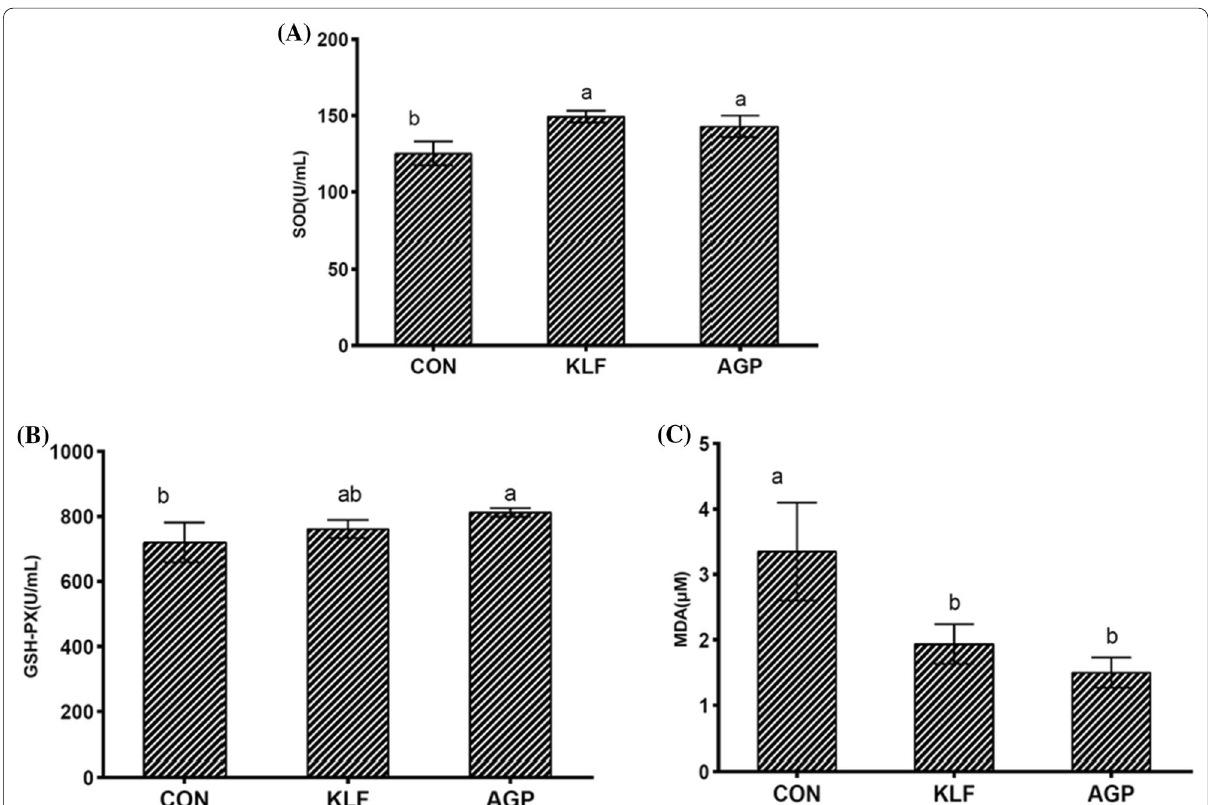
Fig. 1 Serum Anti-oxidant capacity evaluation of CON, KLF, and AGP treatments. A superoxide dismutase (SOD) activity evaluation of CON, KLF, and AGP treatments. B glutathione peroxidase (GSH-PX) activity evaluation of CON, KLF, and AGP treatmentsC, malondialdehyde (MDA) content